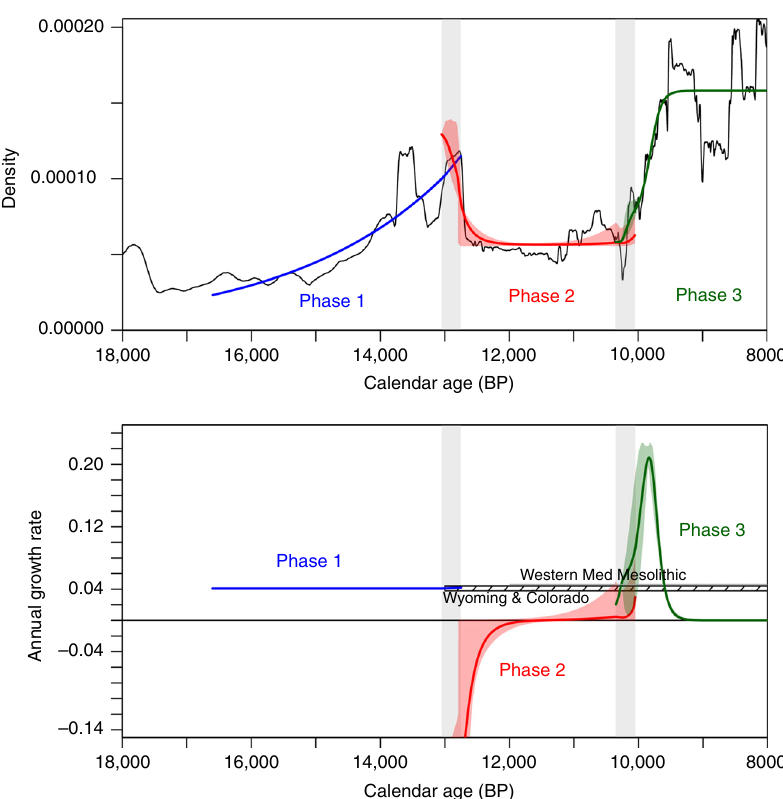
Fig. 5 Regression fi ts and demographic growth rates of the best- fi tting model. Top: Population proxy (in black) and regression fi ts of the best- fi tting model of demographic dynamics. Bottom: Comparison of inferred annual growth rates derived from the best- fi tting model with those derived from other case studies of prehistoric foragers in Wyoming & Colorado 2 and the Western Mediterranean Mesolithic 38 . In both plots, the blue, red and green thick lines and the associated lighter-color shaded areas represent respectively the running mean values and the corresponding 95.4% uncertainties, whereas the grey shaded areas represent the range of breakpoint values